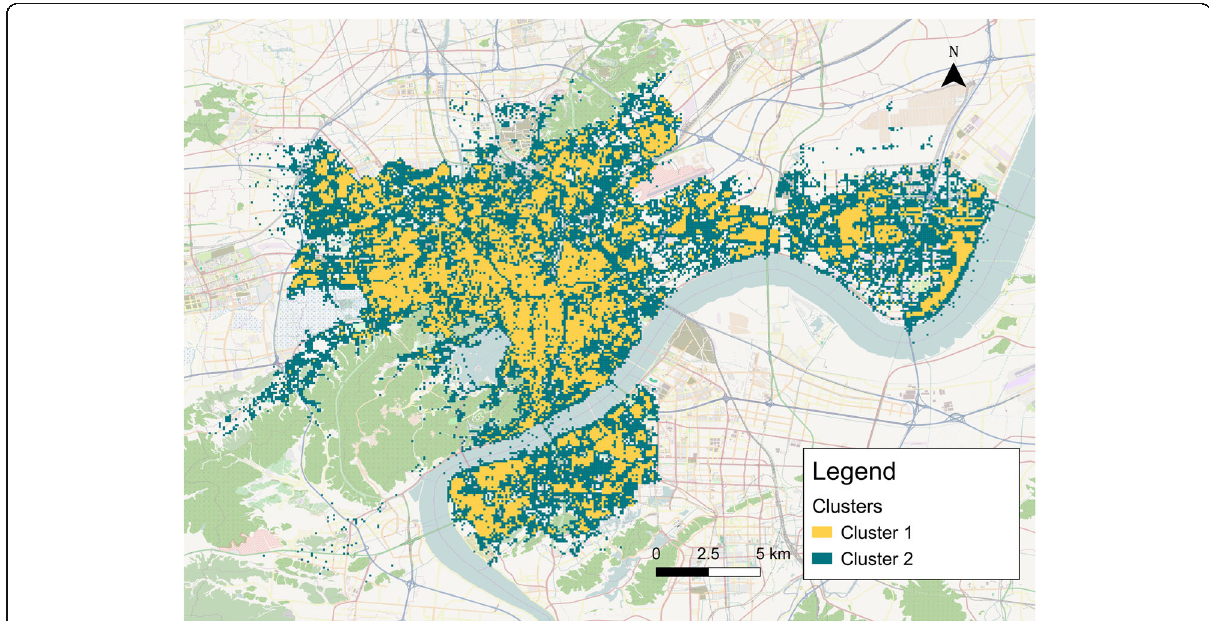
Fig. 7 The spatial distribution of cluster results in the study